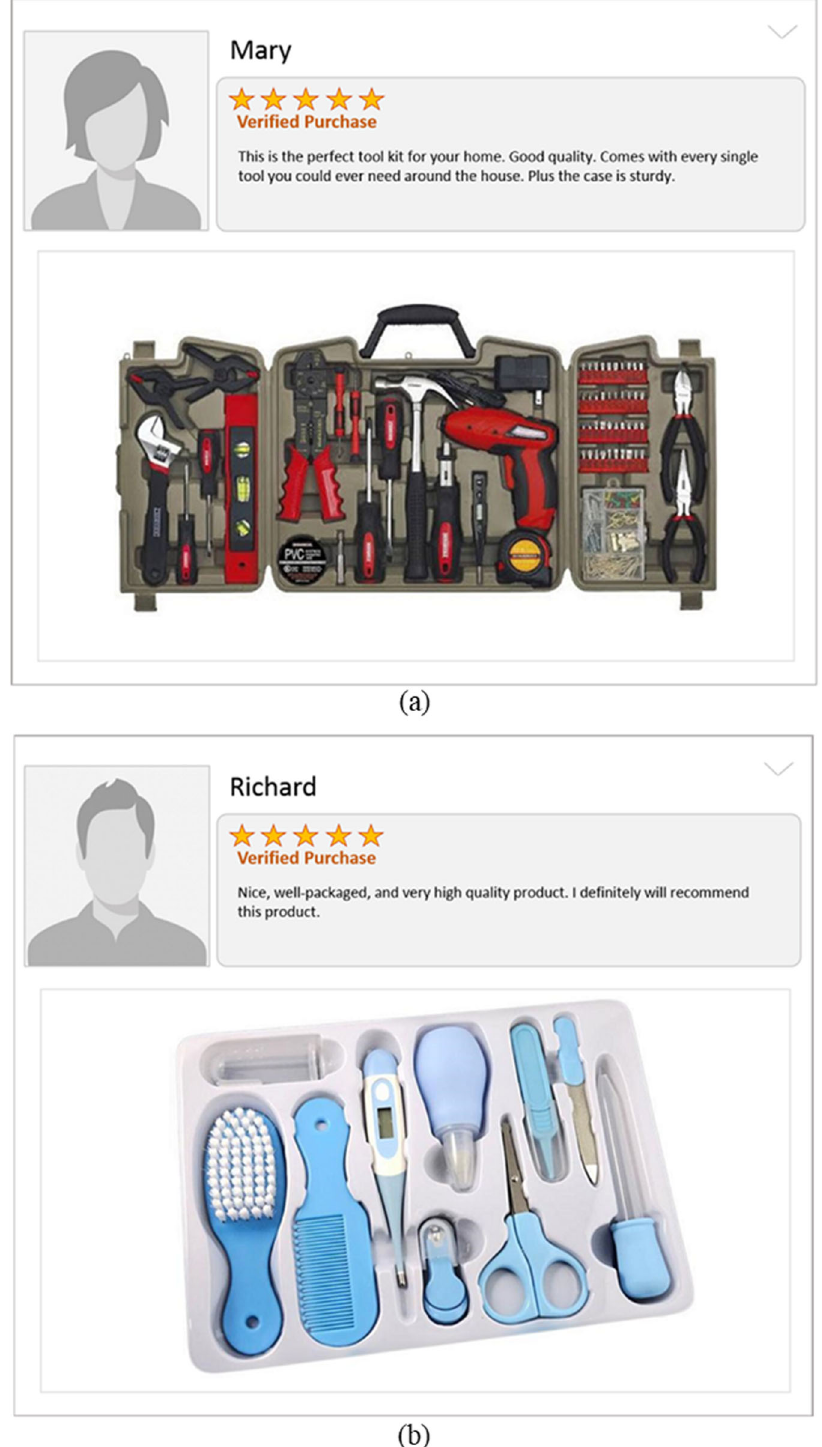
Fig. 1 Example of online review. Contributed by a women and b men. For each of the online reviews in our study, only the avatar, and name were changed to vary